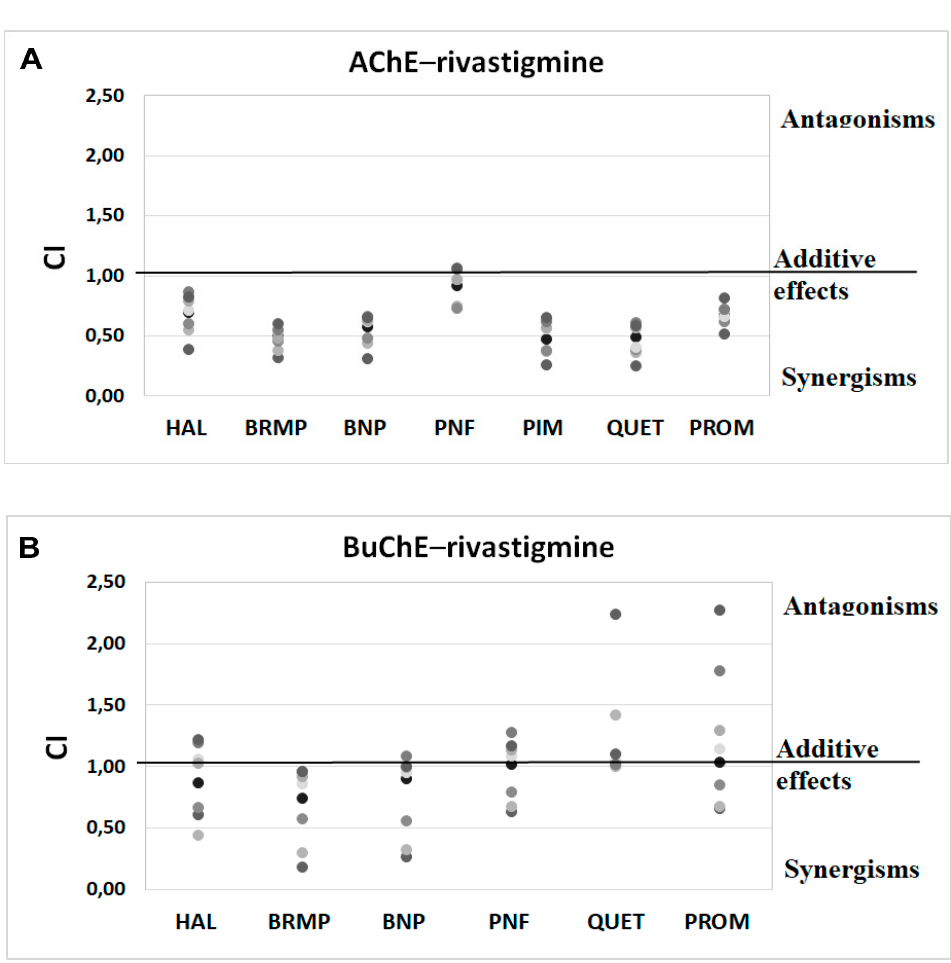
Figure 5. Analysis of potential synergism between rivastigmine (RIV) and haloperidol (HAL), bromperidol (BRMP), benperidol (BNP), penfluridol (PNF), pimozide (PIM), quetiapine (QUET) and promazine (PROM) with the application of the median–effect principle. Data from an AChE ( A ) and BuChE ( B ) inhibitory activities assay were analyzed with the Chou–Talalay method. Results are presented as CI values determined with ComboSyn software for binary mixtures with variable concentration of rivastigmine (range 5–100 µ mol/L for AChE and 0.05–5 for BuChE) and constant concentration of antipsychotic (at their TPC max ). The darker marker means higher concentration of RIV in binary mix. The IC values for an individual concentration of RIV are shown in Table S2 (Supplementary Materials). CI—combination index: where CI < 1, =1 and >1 indicate synergism, additive effect and antagonism, respectively. Figure 5B does not show a relationship between the interaction of rivastigmine/pimozide on BuChE, which ComboSyn calculated to be above 2.5, beyond the scale of the